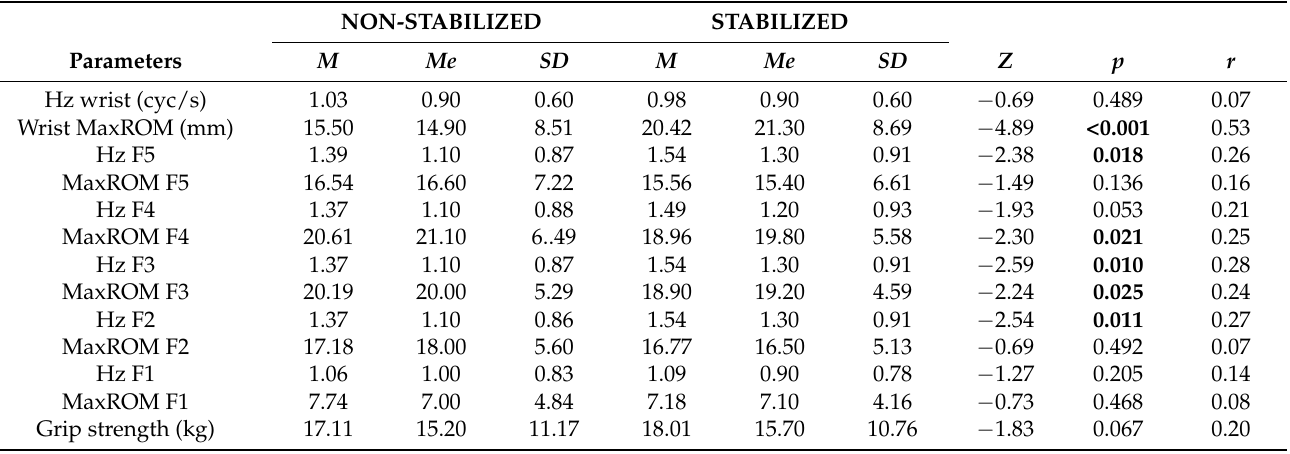
Table 6. Comparison of the results of parameters in the stabilized and unstable position for the age group of 61 years and more after